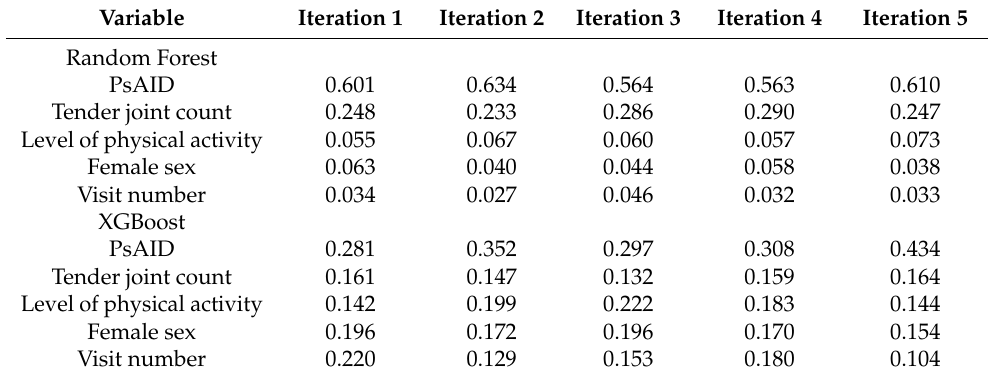
Table 3. Feature importances * of the variables in the different models trained in the cross validation.